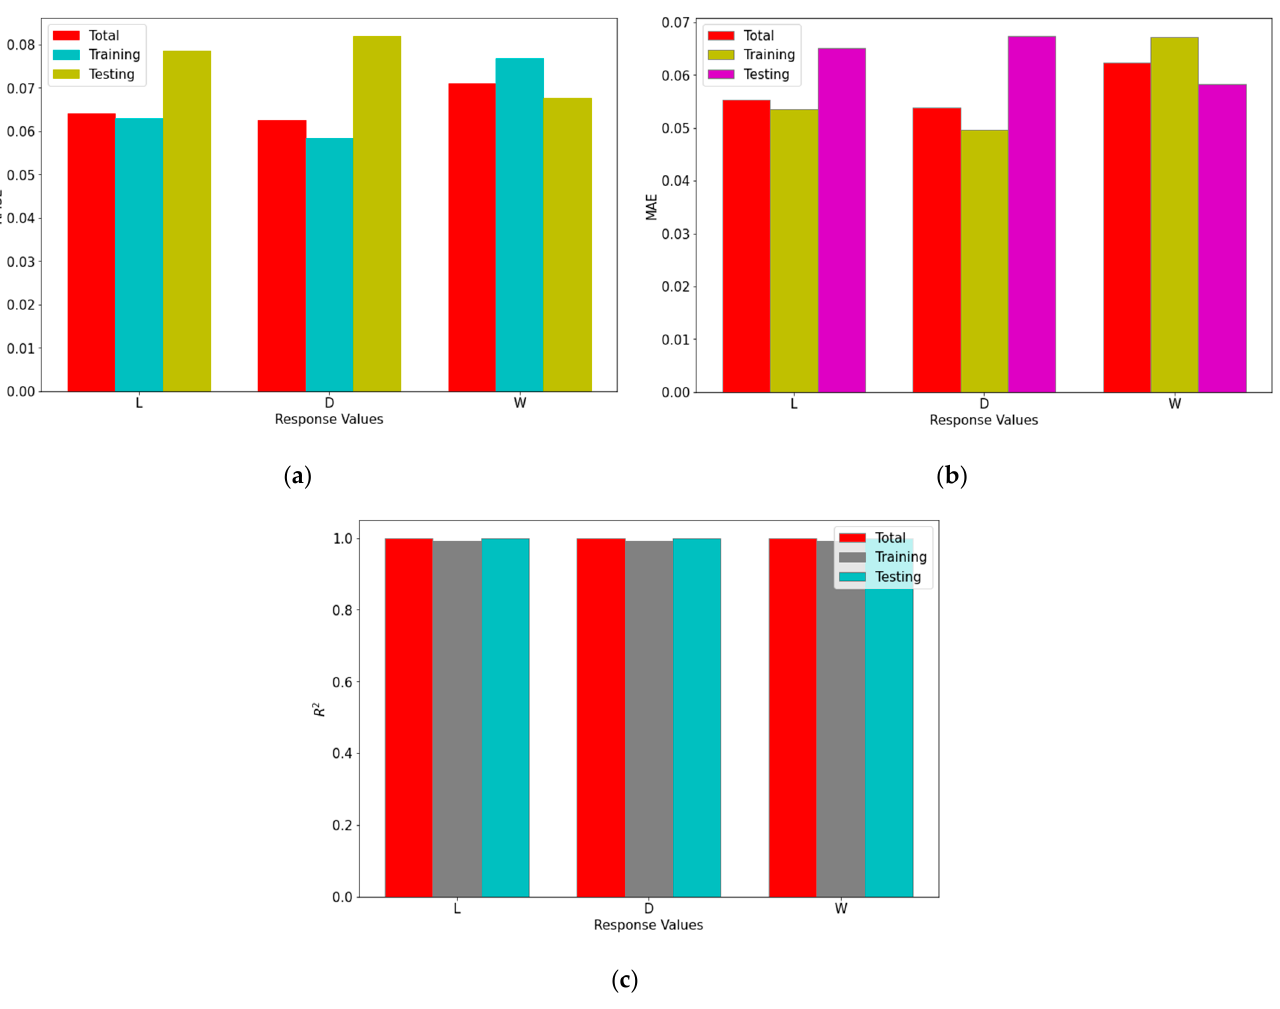
Figure 8. Performance measures of SVR models ( a ) RMSE; ( b ) MAE; ( c ) R 2 .